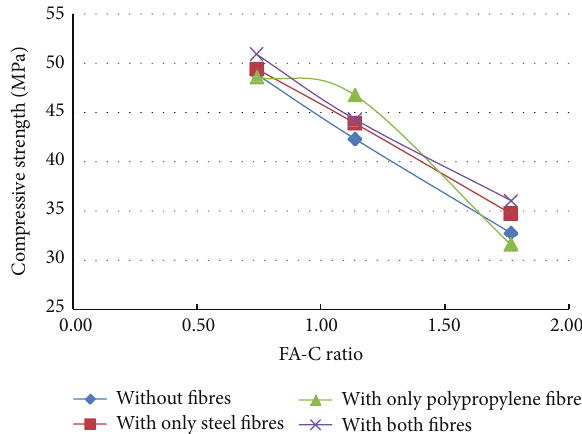
Figure 7: Effect of addition of fibres (CS-S ratio =